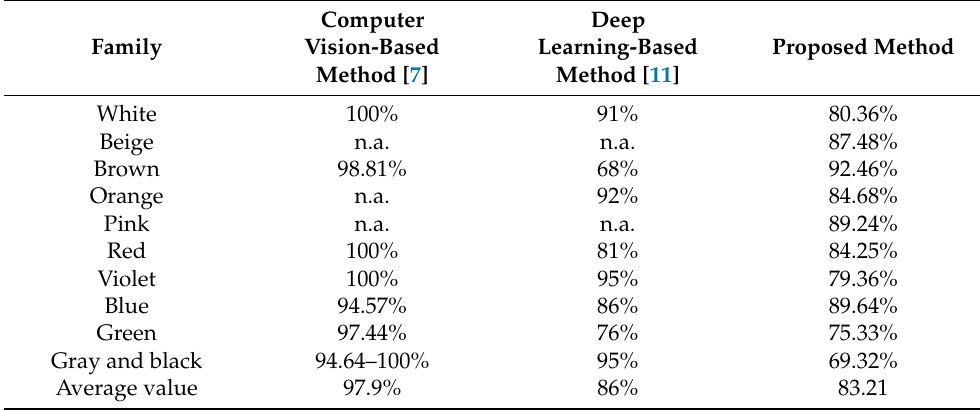
Table 3. Comparison between the proposed method and other